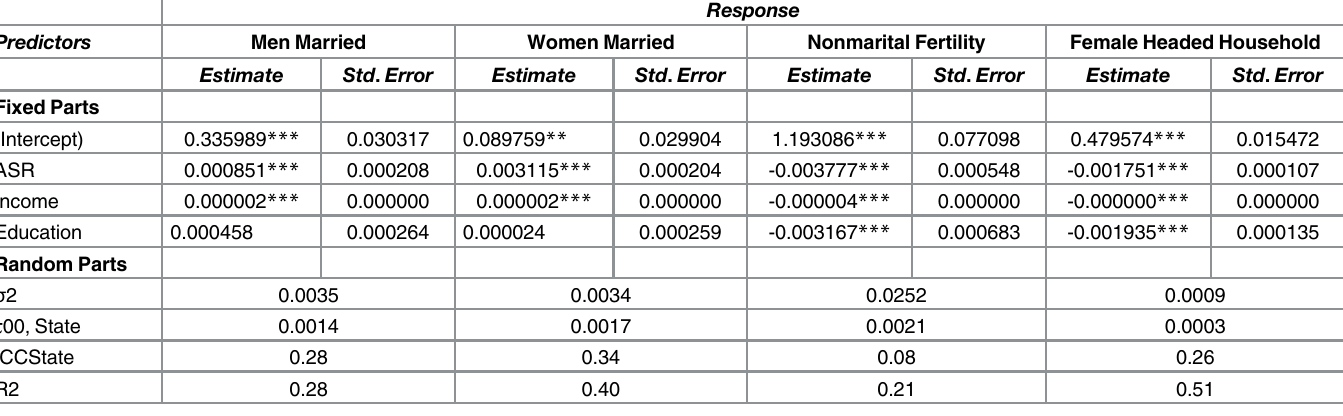
Table 3. Model summaries and parameter estimates for the relationship between fixed and random effects and family formation